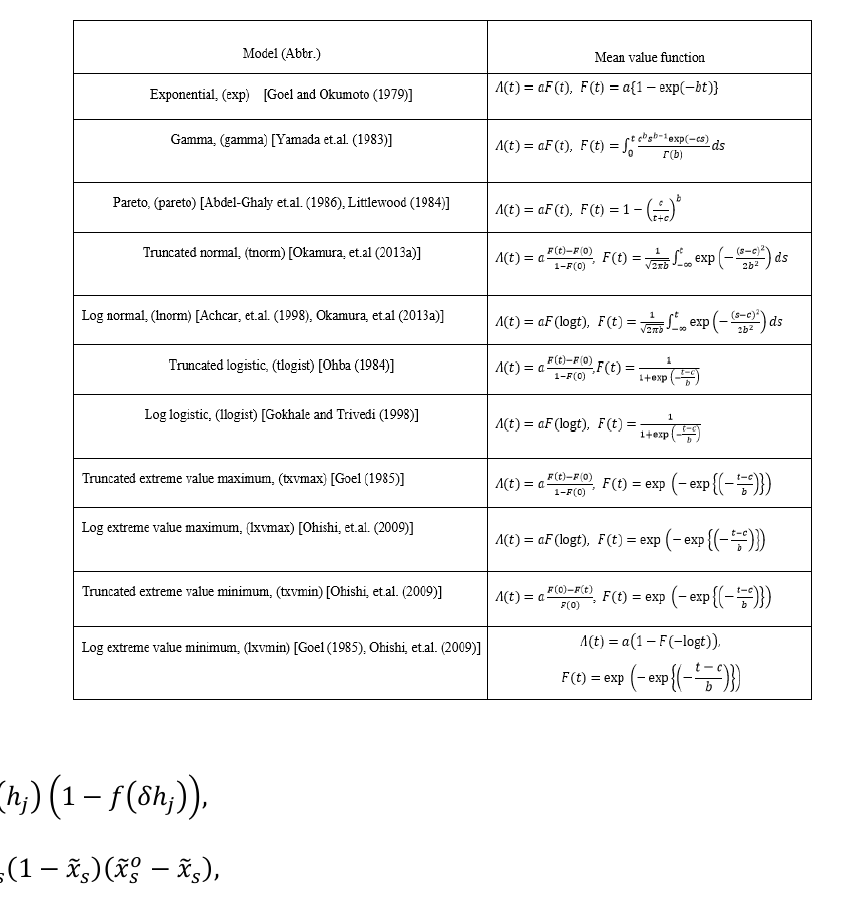
Table 1. NHPP-based SRGMs